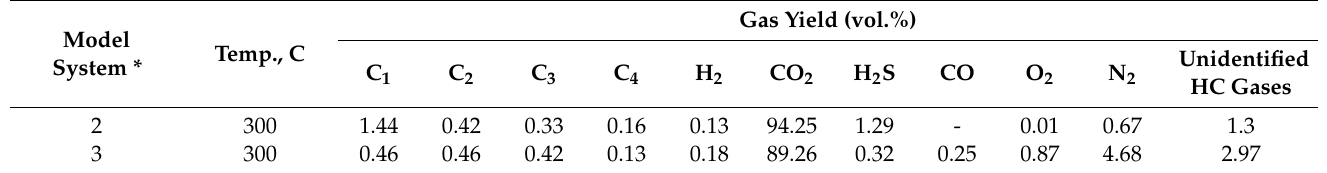
Table 1. The gas components which evolved after the noncatalytic and catalytic hydrothermal